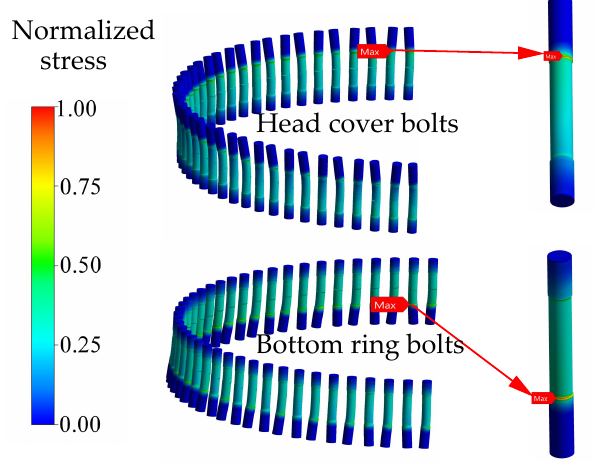
Figure 19. The stress distribution of head-cover bolts and bottom ring bolts. The stress distribution of the large stationary structures, head-cover bolts and bottom ring bolts during turbine load rejection varies with time and keeps the same pattern at different moments. Figure 20 compares the maximum stresses of the stay ring, head-cover bolts, and bottom ring bolts during turbine load rejection. The stresses are normalized with reference to the maximum stress of the head-cover bolts.